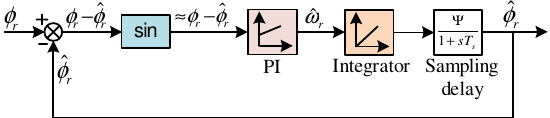
Figure 3. Simplified structure of the traditional MRAS